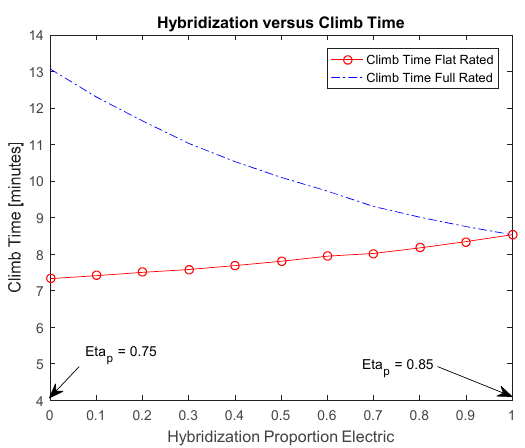
Figure 11. Time to climb vs. hybrid proportion for flat-rated and full-rated ICE.